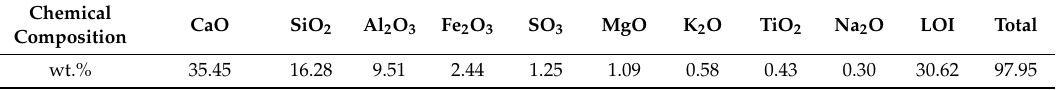
Table 1. Chemical composition of the clinker raw meal (WD-XRF, Thermo Scientific ARL PERFORM’X, Thermo Fisher Scientific, Massachusetts, USA; fused beads, UniQuant program).